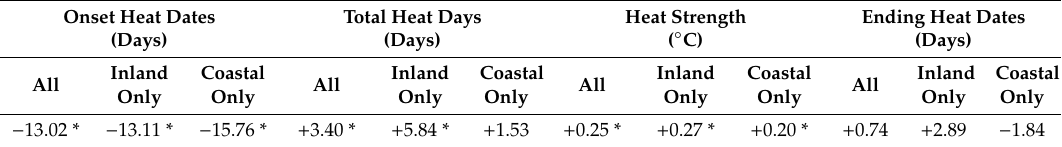
Table 3. The di ff erences between onset heat dates, total heat days, heat strength, and ending heat dates of the eastern and western districts of the Sobaek and the Taebaek mountain ranges in cases of all, inland only, and coastal only stations. Note that the di ff erences were calculated by the values of the eastern districts minus those of the western